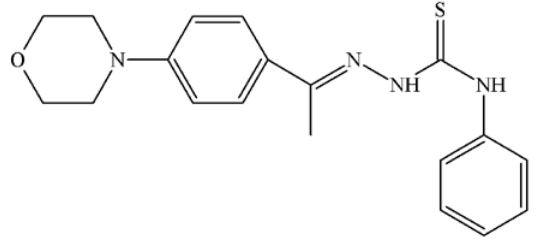
Figure 1. 4’-Morpholinoacetophenone-4-phenyl-3- thiosemicarbazone